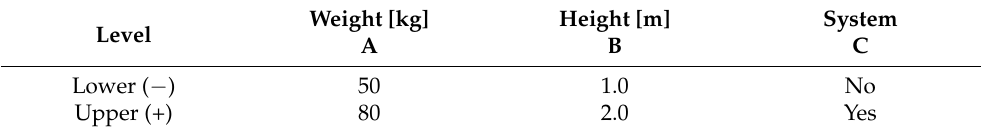
Table 3. Input parameters for the DOE method.